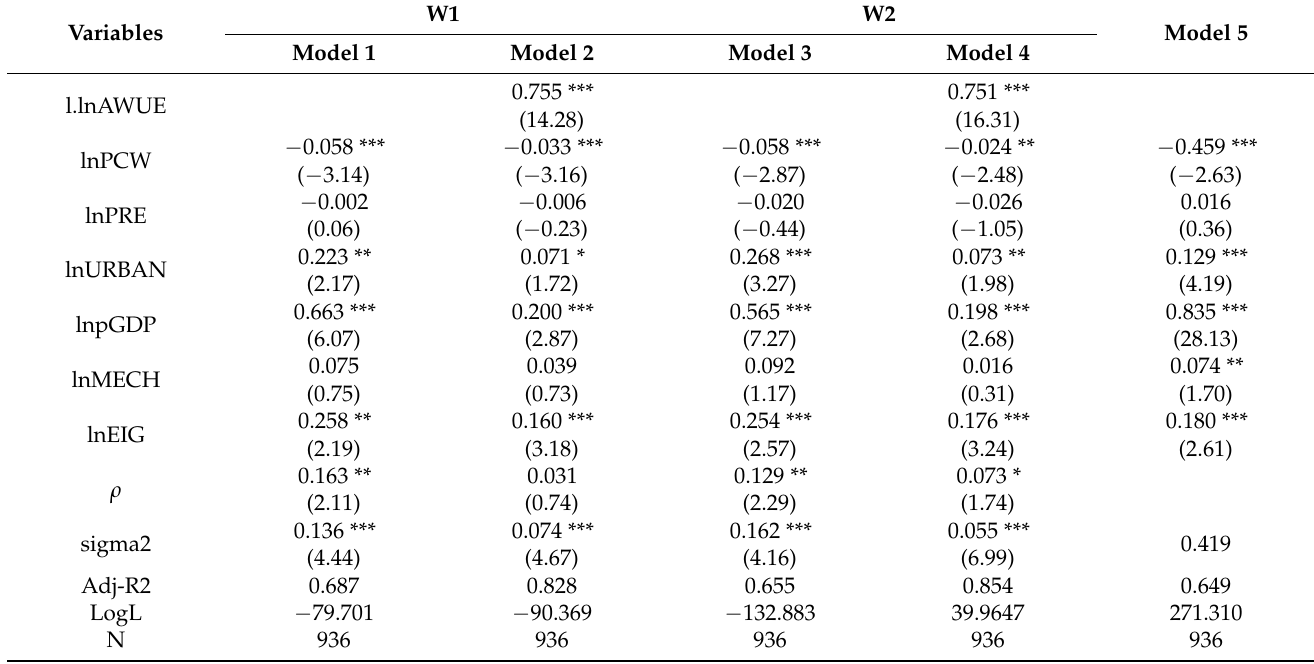
Table 5. Model estimation